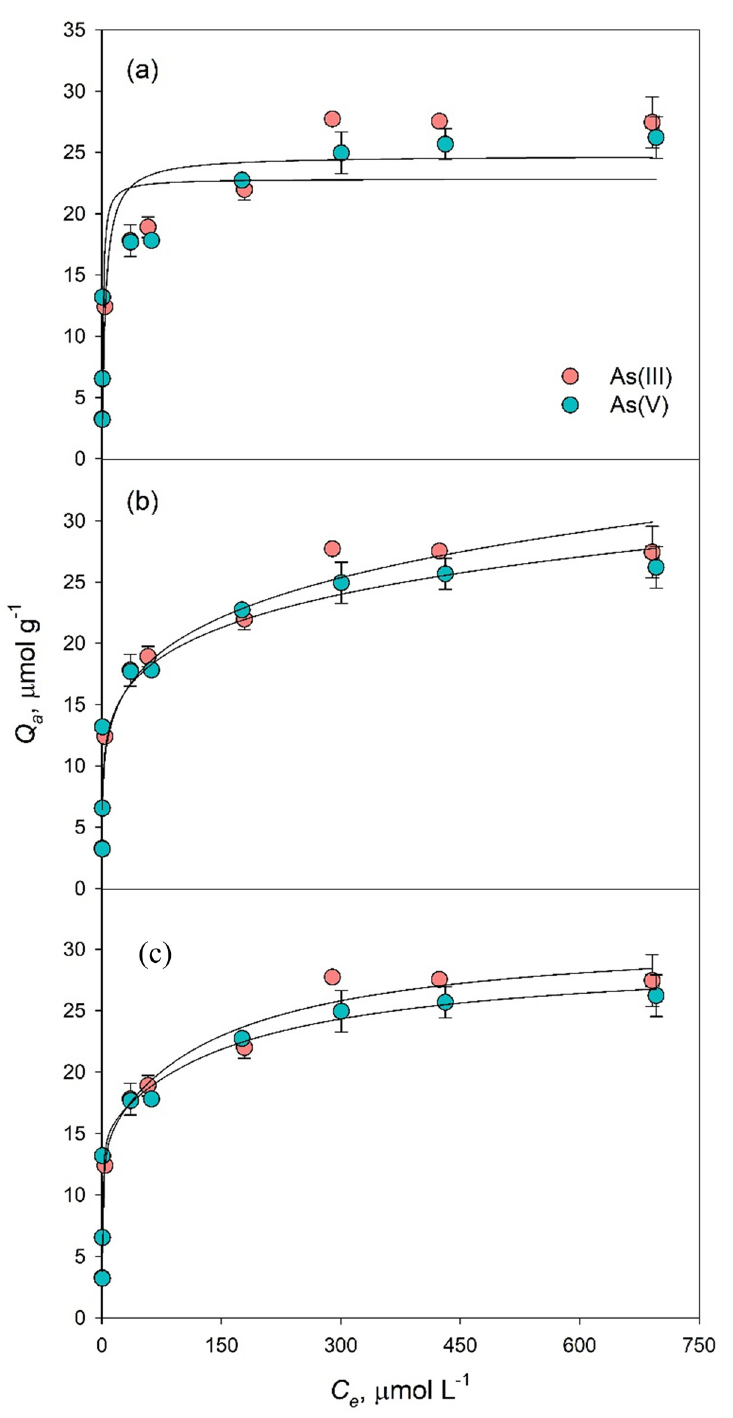
Figure 4. Non-linear Langmuir ( a ), Freundlich ( b ) and two-site Langmuir ( c ) isotherms for As(III) and As(V) adsorption onto Bi 2 O 3 at pH 8 and 7, respectively, and 25 ± 3 ◦ C. Error bars represent the standard error. Where the error bars are not visible, they are smaller than the size of the symbol. We plotted the experimental data of As(III) and As(V) adsorption on Bi 2 O 3 in non- linearized Langmuir, Freundlich, and two-site Langmuir isotherms (Figure 4), which may help understand the mechanisms controlling the partition of the adsorbate between the liquid and the solid phases at equilibrium. The linearized form of the Langmuir and Freundlich equations are presented in Figure